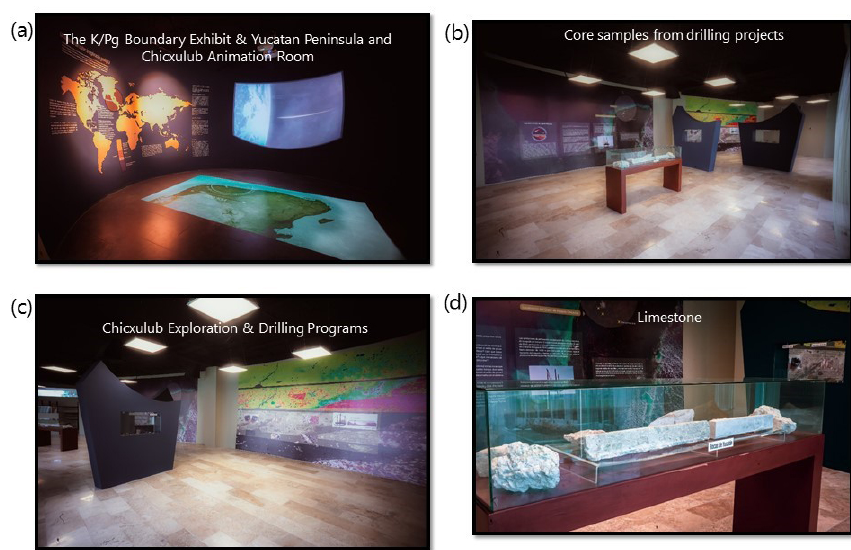
Figure 9. Chicxulub science museum and exhibits of the Chicxulub crater and impacts.